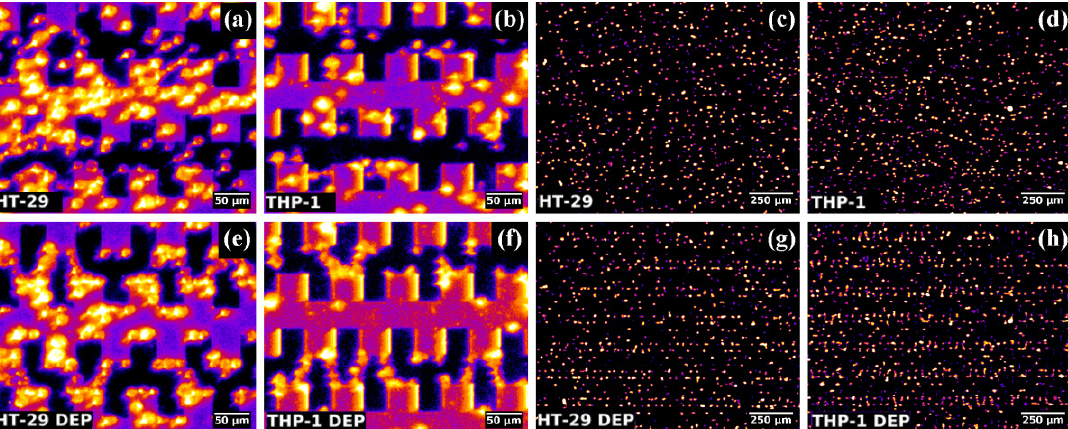
Figure 2. Microscopy images of a cell sample’s (HT-29 and THP-1) distribution before ( a – d ) and after